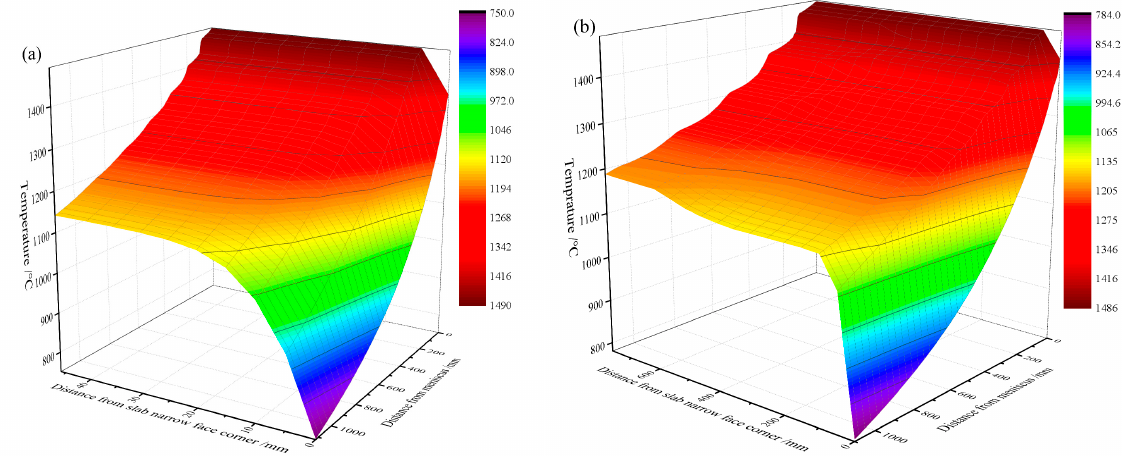
Figure 3. Surface temperature distribution of slab under typical working conditions. ( a ) Narrow face temperature. ( b )Wide surface temperature.